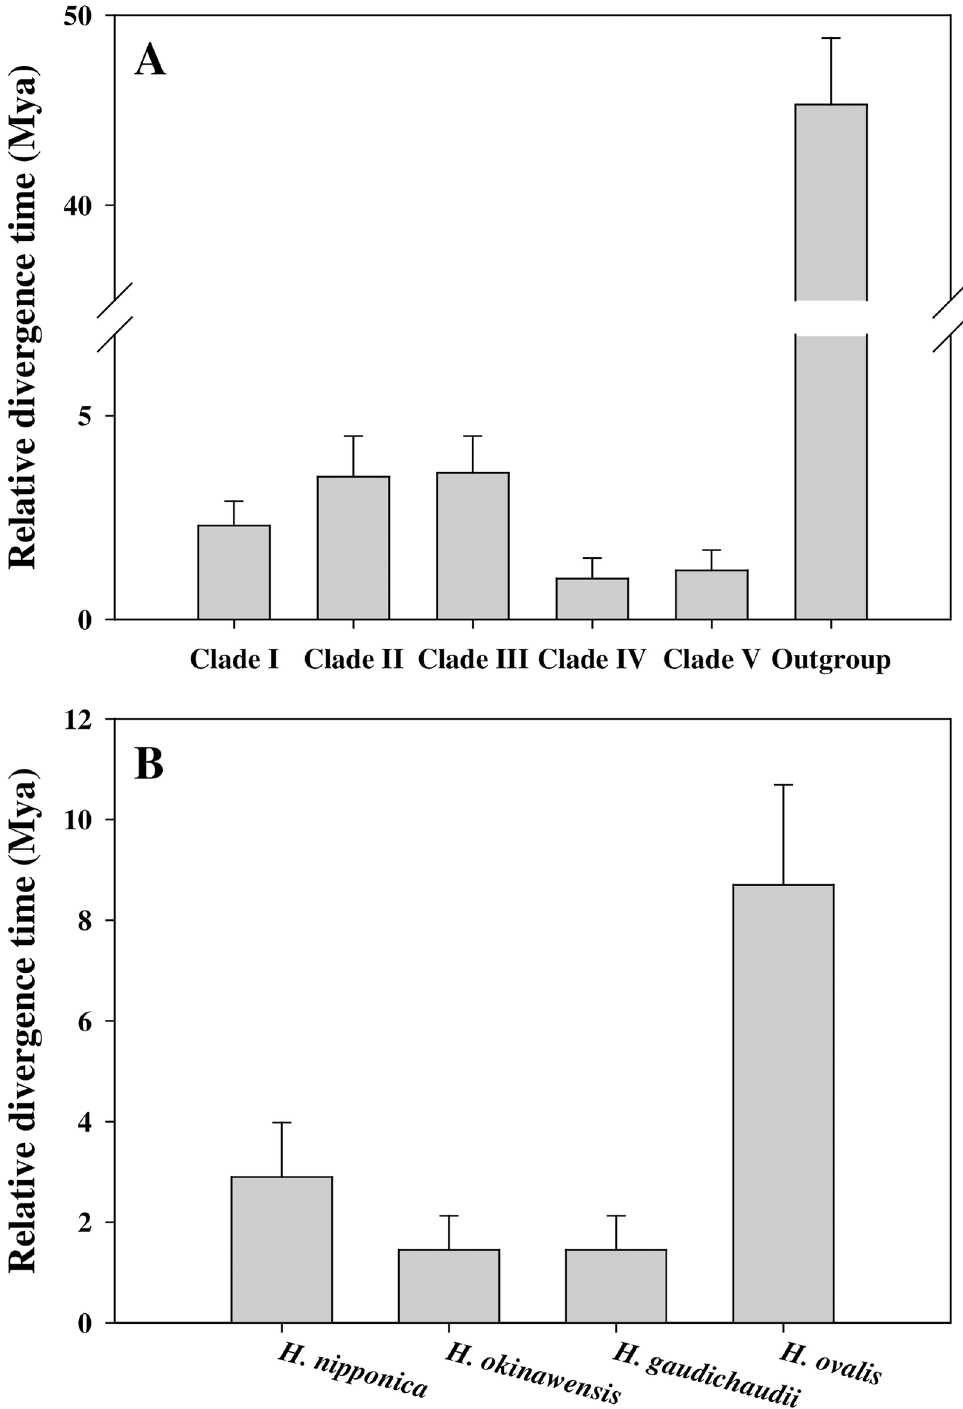
Fig 4. Relative divergence time estimatesof five clades in the section Halophila (A), and the Halophila species ( H . nipponica , H . okinawensis , and H . gaudichaudii ) in Clade I and H . ovalis in Clade II (B). Relativedivergence time was estimated by ITS sequencediversity using the NETWORK 4.6 program. Values are mean ± SD.